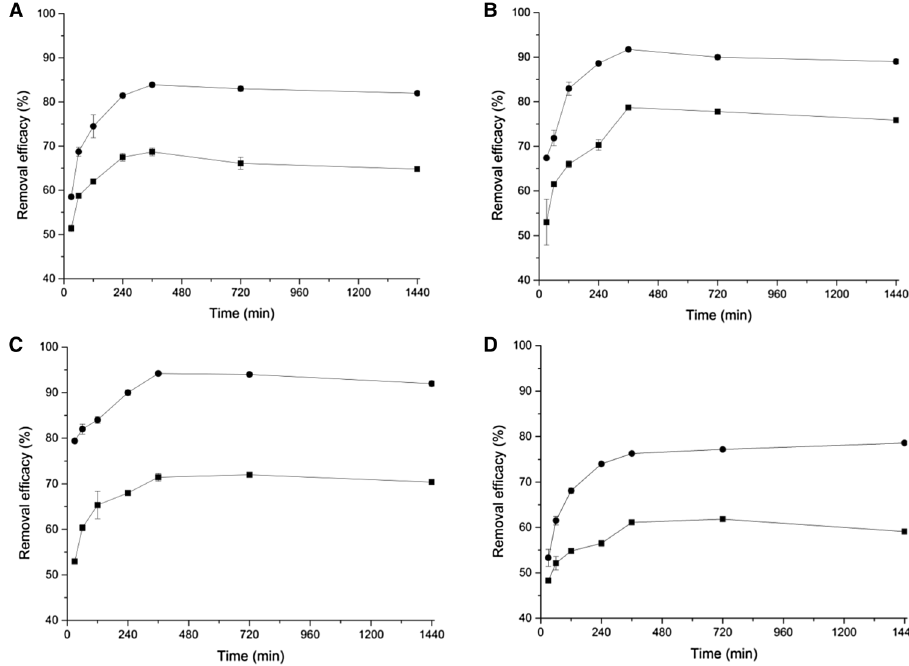
Fig. 1 Pesticide removal effi‑ ciency atrazine ( a ), chlorpyrifos ( b ), fluazifop ( c ), and lactofen ( d ) in soils containing high concentrations of organic matter (filled circle) and low concen‑ trations of organic matter (filled